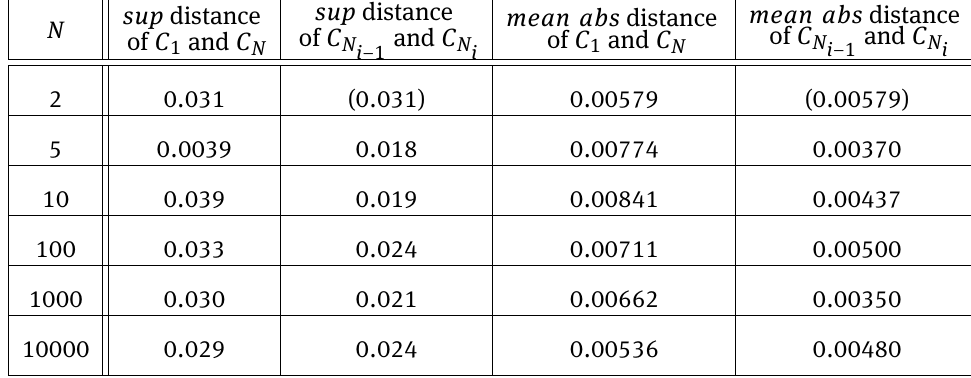
sup distance N of C 1 and C